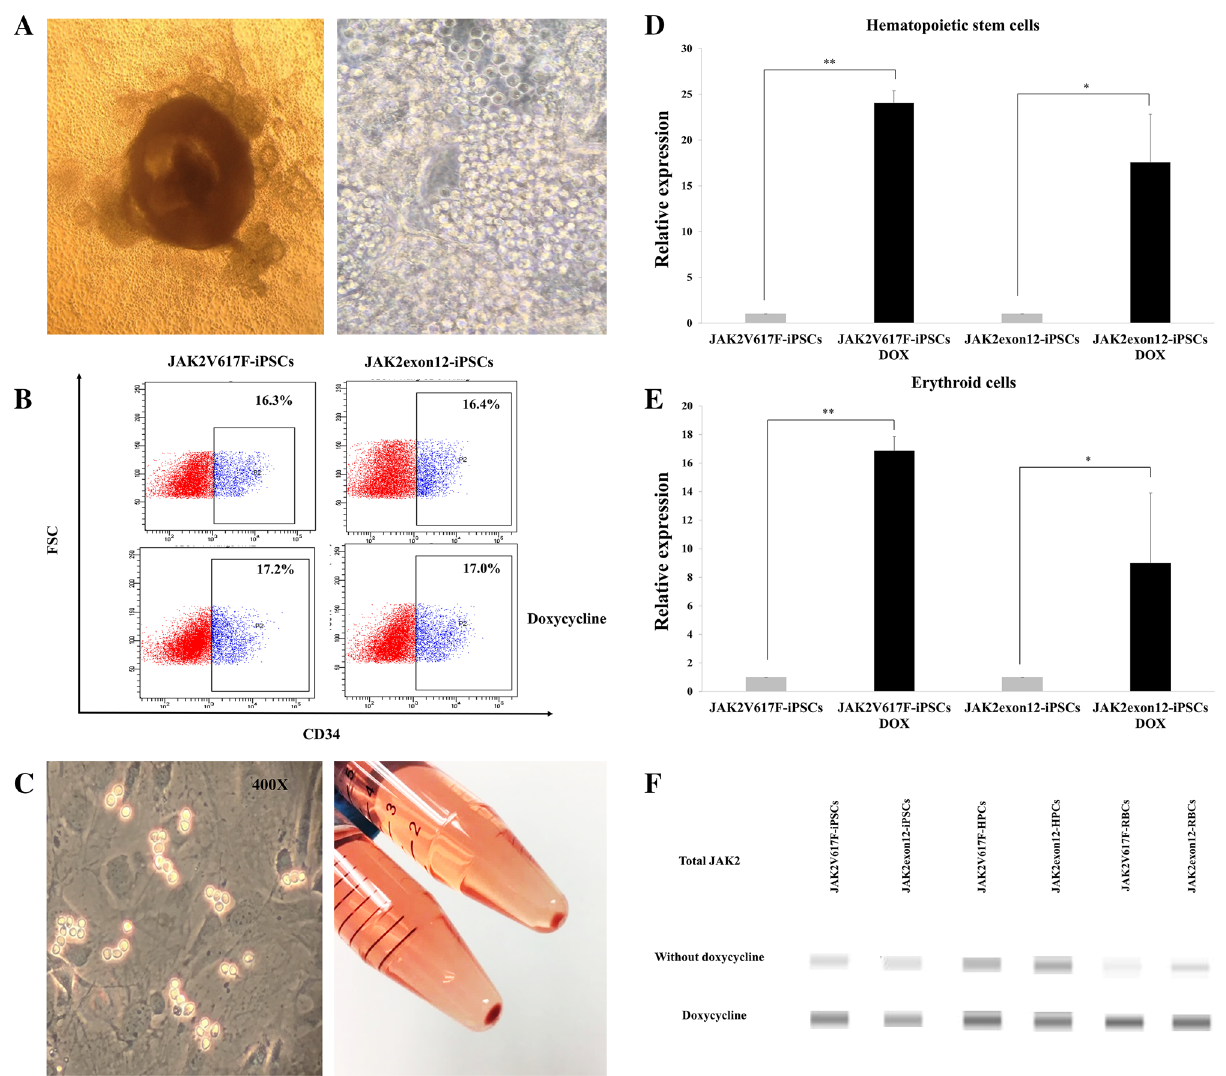
Figure 3. Erythroid cell differentiation from modified induced pluripotent stem cells (iPSCs) via ES-Sacs. ( A ) ES-derived sacs containing hematopoietic progenitor cells were generated from modified iPSCs on day 14 at ×100 and ×400 magnifications. ( B ) The percentages of CD34 + cells derived from JAK2V617F-iPSCs and JAK2exon12-iPSCs were similar with or without doxycycline. ( C ) Erythroid cells in a culture plate and red blood cell pellets after centrifugation. ( D ) Expression mRNA levels of exogenous JAK2 in hematopoietic progenitor cells determined by real-time quantitative RT-PCR. ( E ) Expression mRNA levels of exogenous JAK2 in erythroid cells. ( F ) The capillary Western immunoassay showed total JAK2 proteins from JAK2V617F-iPSCs and JAK2exon12-iPSCs at the induced pluripotent stem cell, hematopoietic progenitor cell (HPC) and erythroid cell (RBC) stages in the conditions with vs. without doxycycline. Each band was electrophoresed in a separate capillary tube. The full blot is presented in the Supplementary Fig.